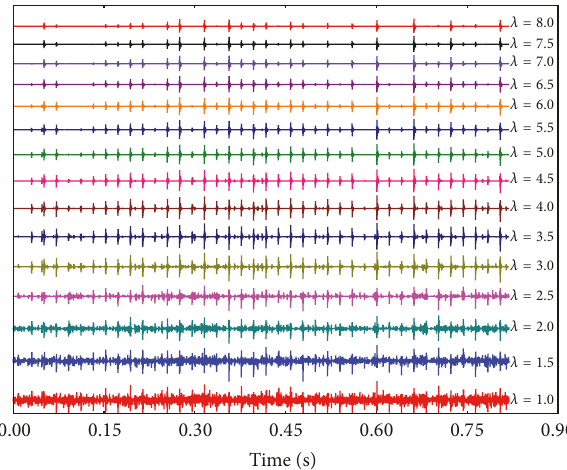
Figure 4: The impulses with different sparse